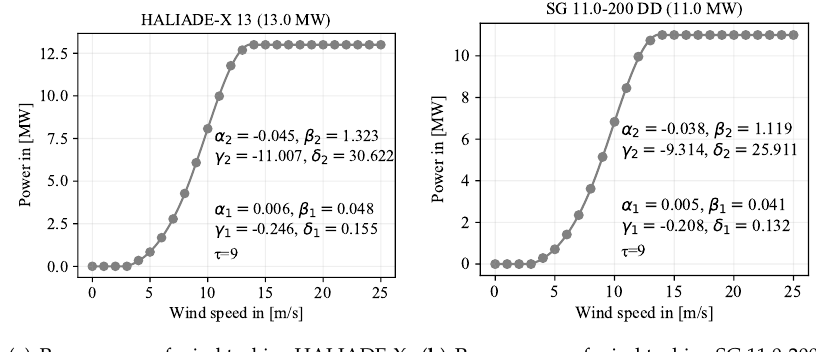
( a ) Power curve of wind turbine HALIADE-X 13.